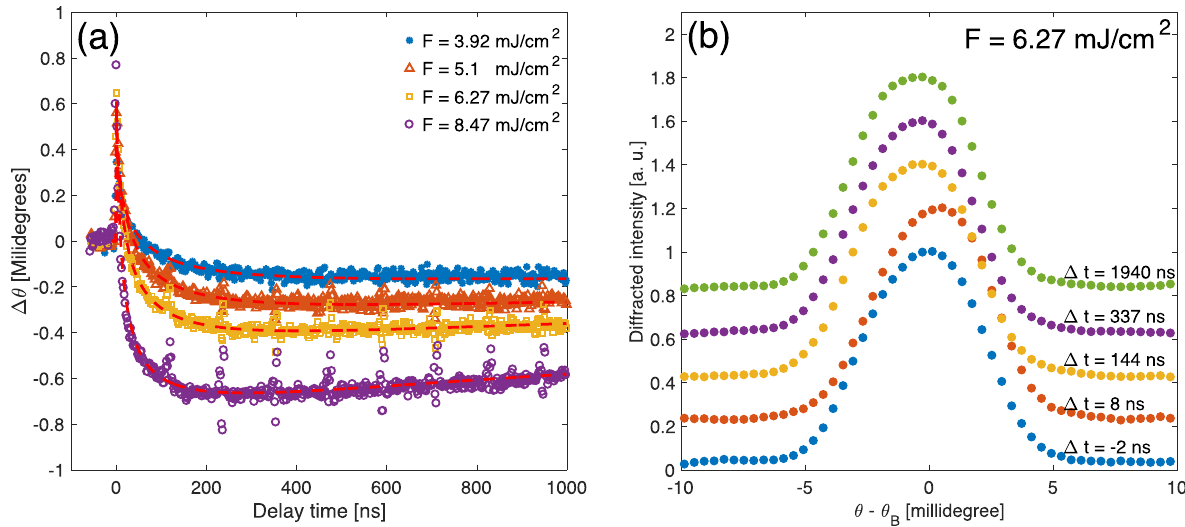
Figure 2. ( a ) Centroid shifts after the photo excitation with laser fluences. The red dashed lines represent the model-based numerical calculation result. ( b ) Temporal evolution of Si (0 0 4) X-ray rocking curves at F = 6.27 mJ/cm 2